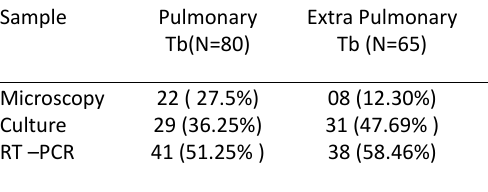
Table 2 . Comparison of Microscopy, Culture and RT PCR for pulmonary and extra pulmonary samples